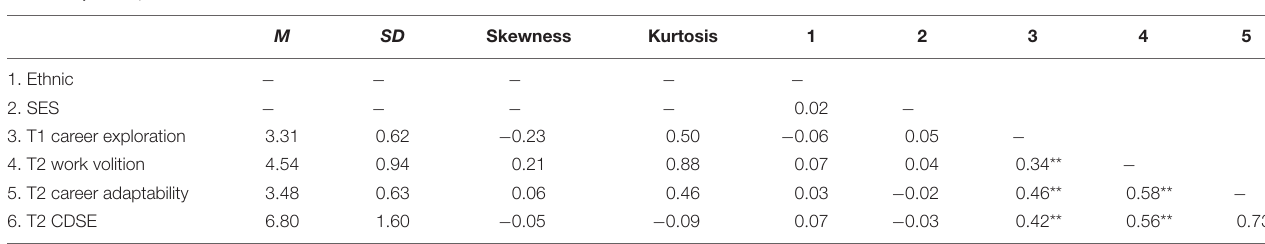
TABLE 1 | Descriptive statistics and